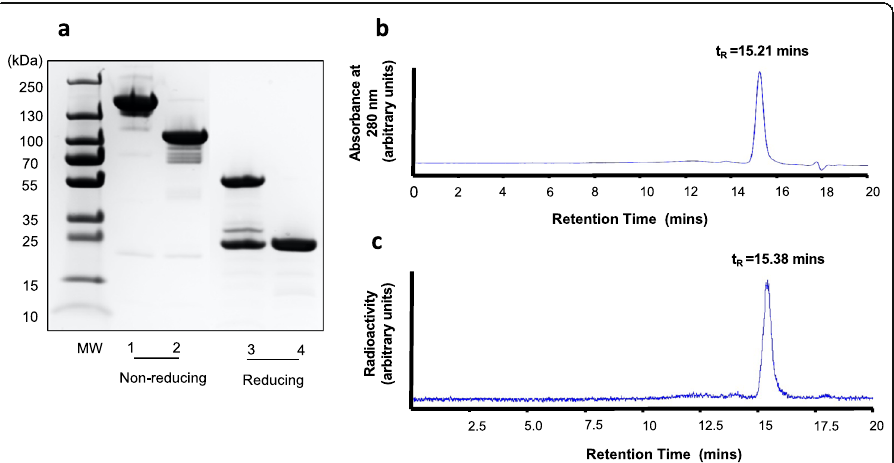
Fig. 1 a. SDS-PAGE analysis of panitumumab IgG and F(ab´) 2 under non-reducing (lanes 1, 2, respectively) or reducing (lanes 3, 4, respectively) conditions on a 7.5% Tris/Glycine mini-gel stained with Coomassie blue. b. SE-HPLC chromatogram of [ 64 Cu]Cu-DOTA-panitumumab F(ab´) 2 analyzed on a BioSep SEC-4000 column eluted with NaH 2 PO 4 buffer, pH 7.0 at a flow rate of 0.5 mL/min with UV detection at 280 nm. C. SE- HPLC chromatogram of [ 64 Cu]Cu-DOTA-panitumumab F(ab´) 2 with radioactivity detection. Integration of the peak with t R = 15.21 mins on the chromatogram with UV detection indicated a purity for DOTA- panitumumab F(ab´) 2 of 96.1%. Integration of the peak with t R = 15.38 mins on the chromatogram with radioactivity detection indicated a radiochemical purity for [ 64 Cu]Cu-DOTA-panitumumab F(ab´) 2 of